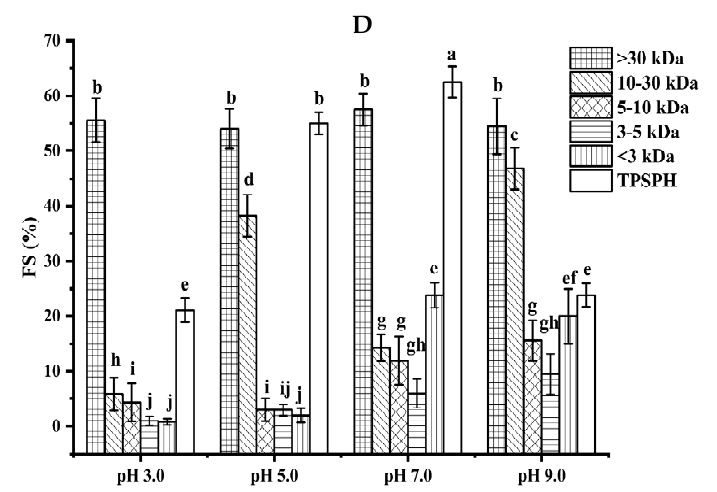
Figure 4. Functional properties of TPSPH and five fractions. ( A ) Emulsifying activity index (EAI). ( B ) Emulsion stability index (ESI). ( C ) Foaming capacity (FC). ( D ) Foaming stability (FS). Different letters indicate significant differences ( p < 0.05).